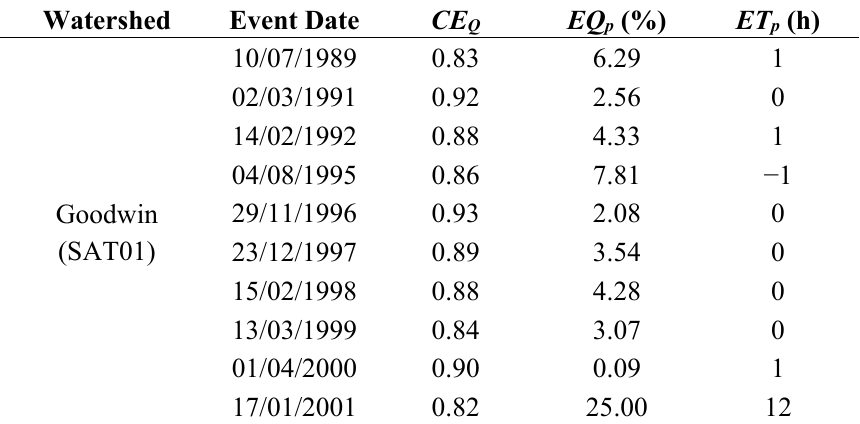
Figure 6. Flow forecasting using measured rainfall data and without flow updating in Goodwin Creek and San-Hsia watersheds: ( a ) Goodwin Creek watershed (STA 01); ( b ) San-Hsia watershed. Table 4. Results of flow forecasting using measured rainfall and without flow updating